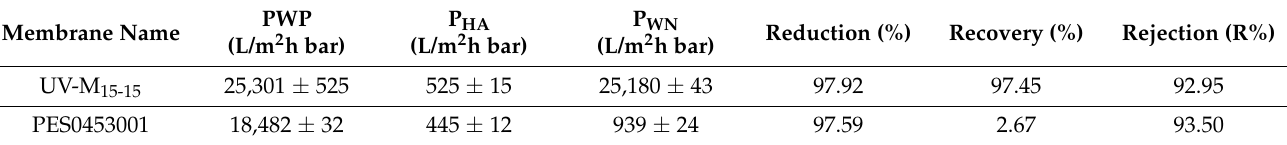
Table 4. The permeability and anti-fouling properties of the UV-M 15-15 and commercial PES membranes .